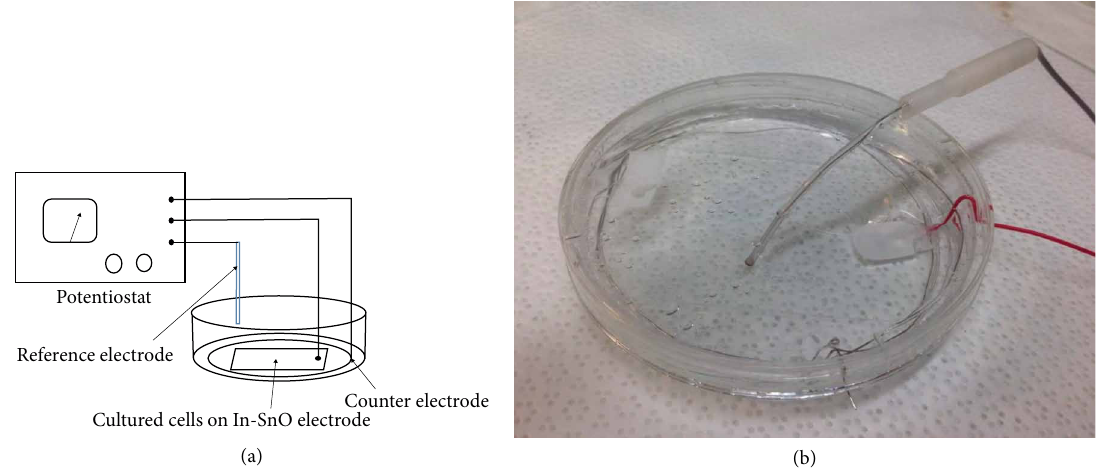
Figure 1: The electrochemical setup used to oxidize live mammalian cells (a) schematic diagram and (b) image of the electrochemical